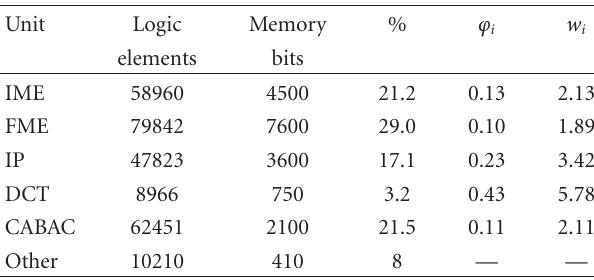
Table 1: Hardware usage of a H.264 encoder with a Virtex-5 FPGA (XCV5LX155T-2) device.